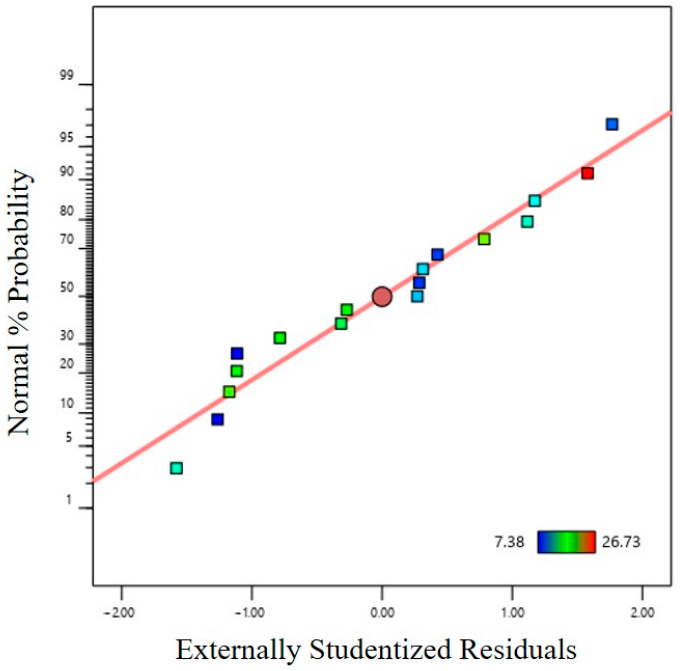
Figure 5. Normal probability distribution of residual.